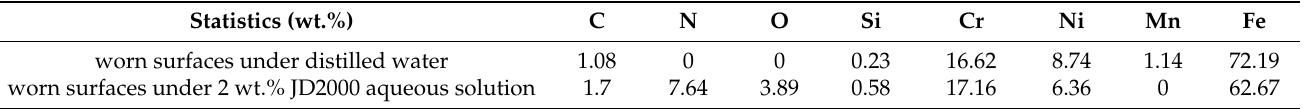
Table 1. Element contents of the friction-tested steel Figure 14. The MS spectra of the friction-tested steel plates lubricated by the 2 wt.% JD2000 aque- ous solution.